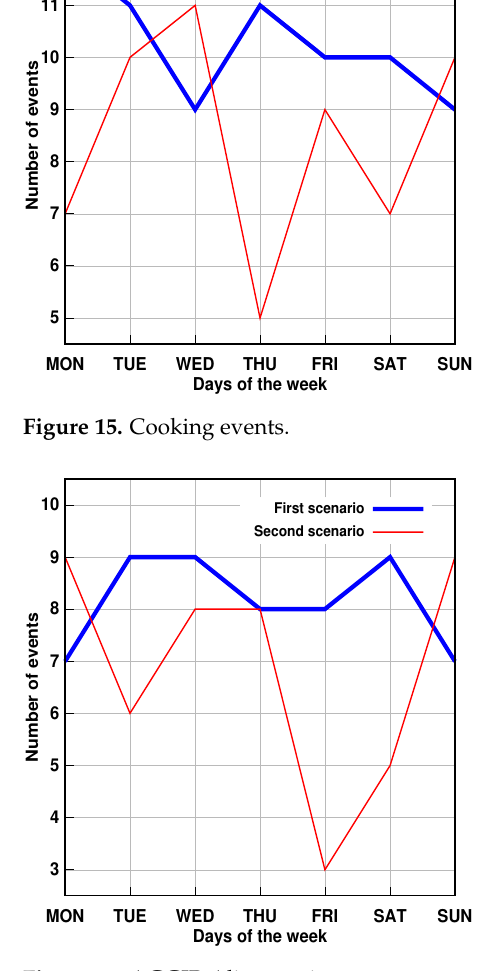
Figure 16. AGGIR Alimentation